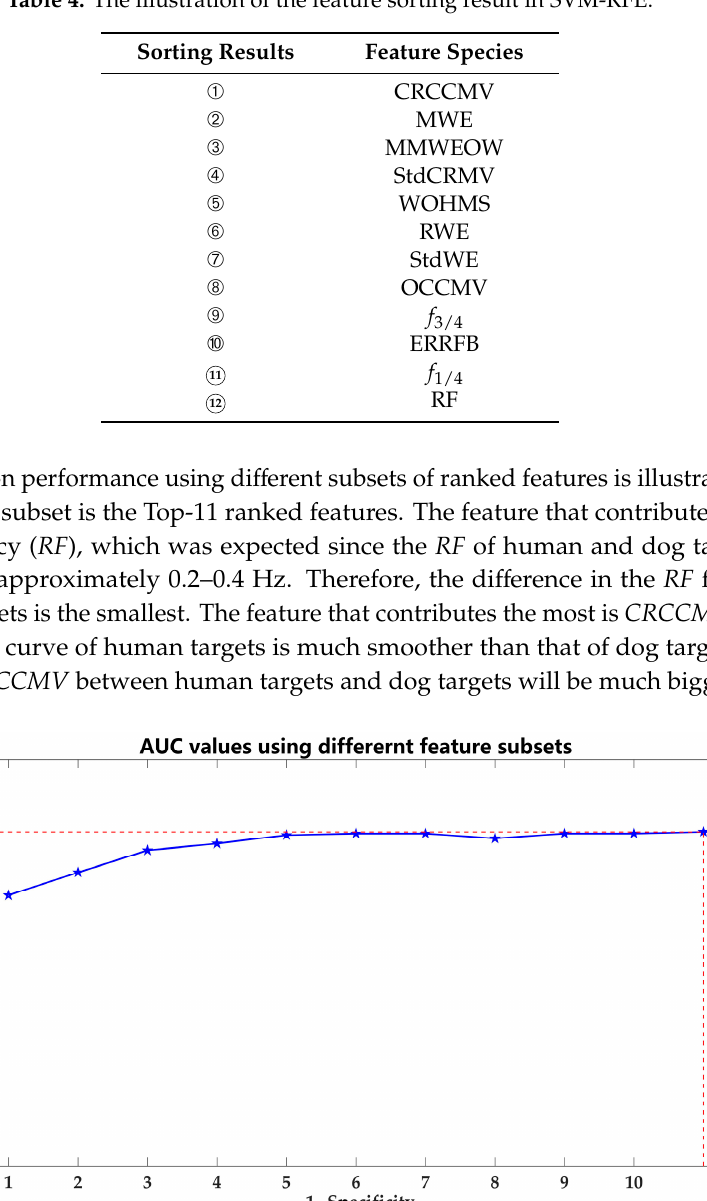
Table 4. The illustration of the feature sorting result in SVM-RFE.